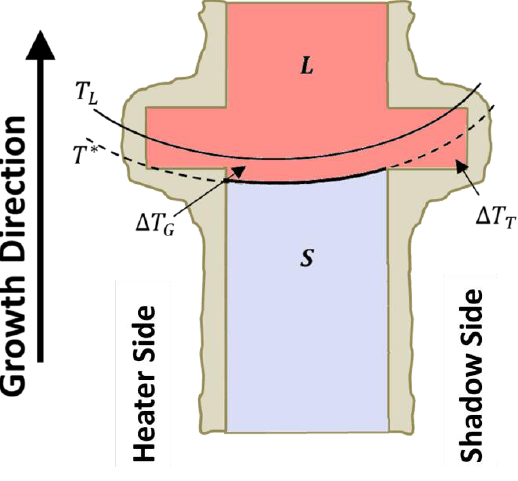
Figure 11. Schematic illustration of the thermal conditions in a dummy turbine blade during transition of the solidification front from blade to platform area. T L : curved liquidus isotherm; T *: temperature of the undercooled solidification front; Δ T G : growth supercooling; Δ T T : thermal undercooled